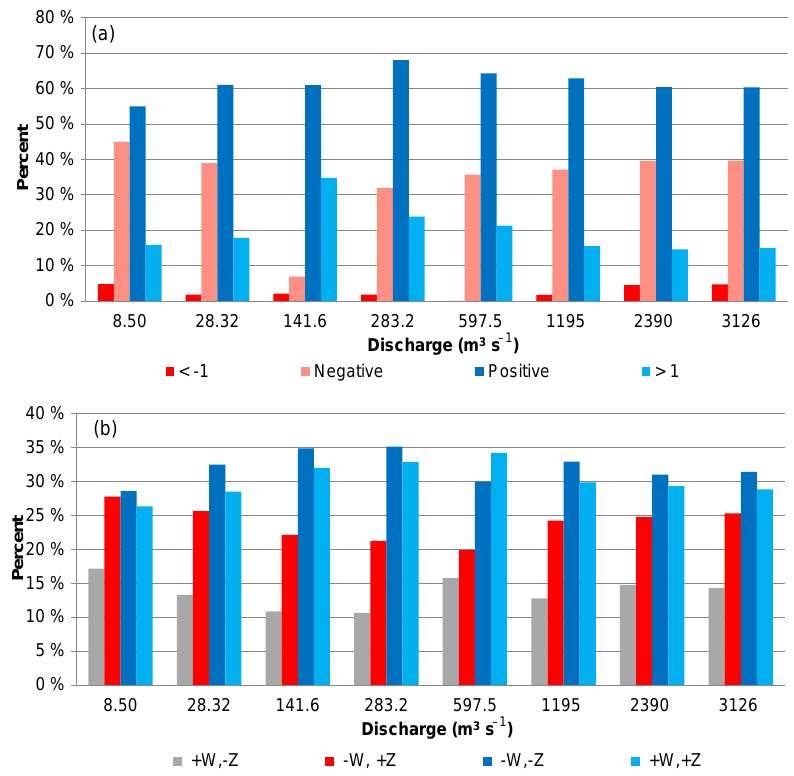
Figure 6. Histogram of C ( ZW j ) classified by positive and negative values as well as >1 and <1 (a) . Also shown is a histogram classified by quadrant (b) . The top histogram (a) illustrates the dominance of values C ( ZW j ) > 0 regardless of discharge and also illustrates an increasing tendency towards positive values of C ( ZW j ) > 1 up until 141.6m 3 s − 1 , after which it declines. The bottom histogram (b) illustrates the distribution of the four quadrant types shown in Fig. 3, with shallow and wide (e.g., + W , + Z ) and deep and narrow (e.g., − W, − Z) zones being most dominant at 283.2 3 s − 1 . Colors represent bin-centered